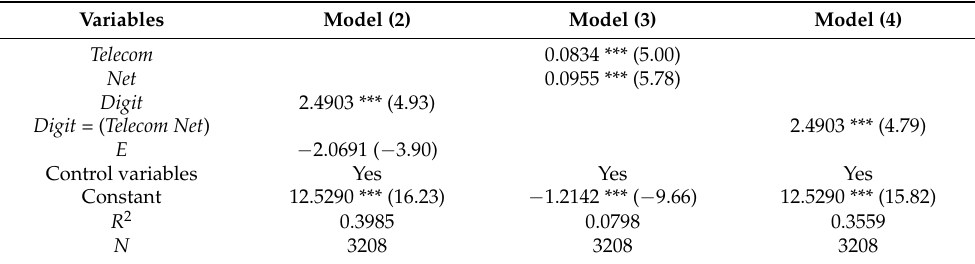
Table 7. Endogeneity test of instrumental